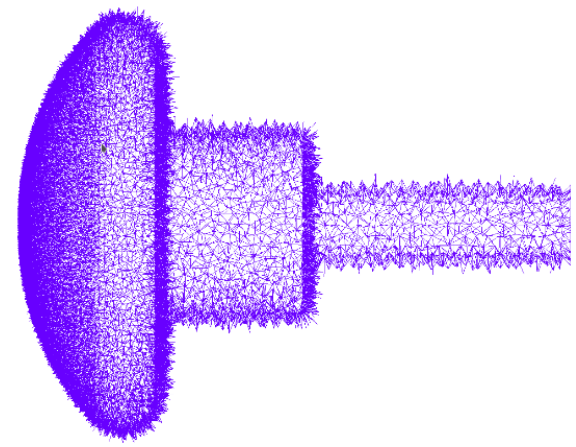
Figure 3. The 51,679 edges corresponding to the relative cohomology between the oil volume and the electrode surface, to obtain the incidence vector I c from Equation (15).